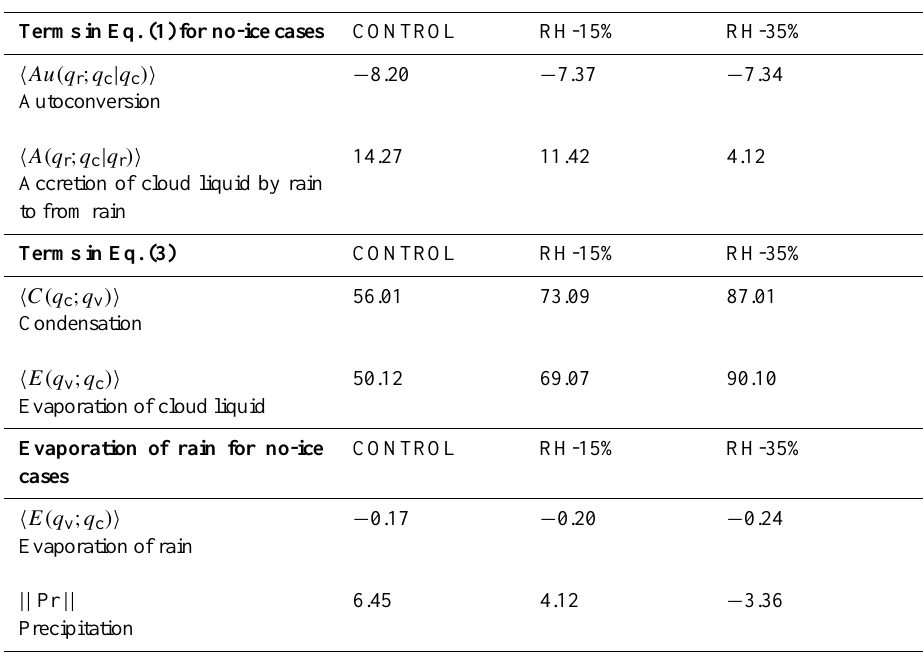
Table 3. Domain-averaged differences in the accumulated sources and sinks of precipitation, retained in the approximated Eqs. (1) and (3), and the domain-averaged differences in the accumulated evaporation of rain between the high-aerosol-no-ice and low-aerosol-no-ice runs.